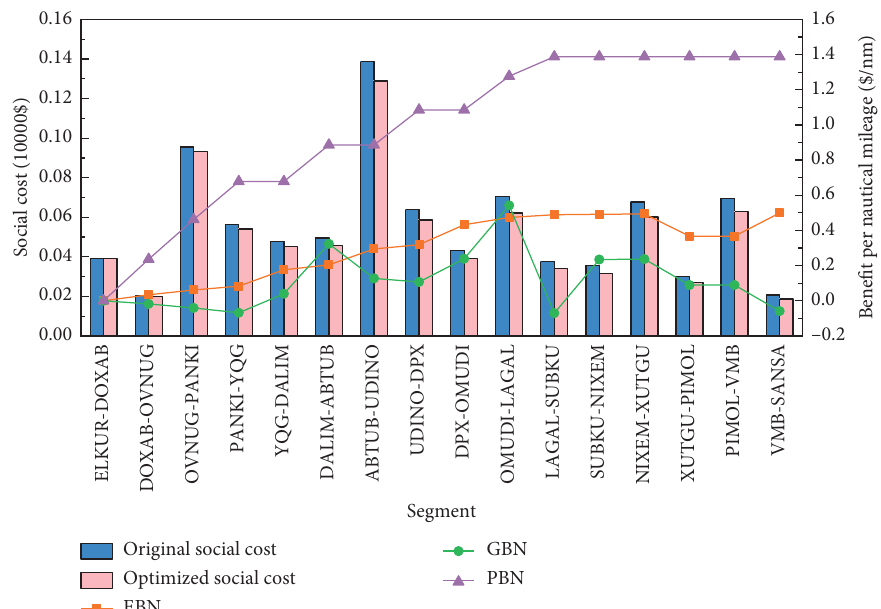
Figure 4: The original and optimized social cost of CHH7605 and various benefits per nautical mileage of SATO in different